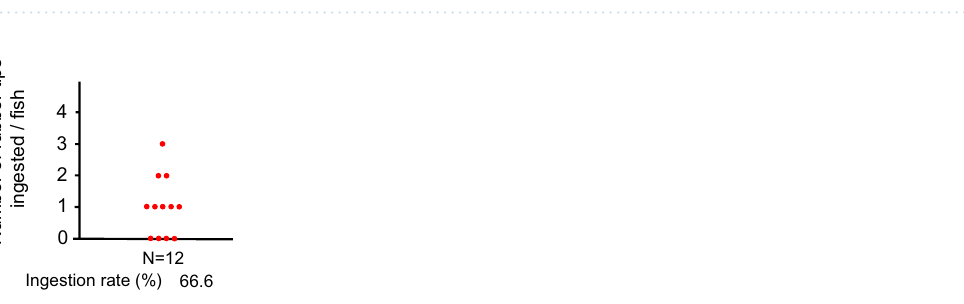
Figure 3. Co-ingestion of rubber tips (ICU) and fish feed by goldfish of different body sizes. Fish were fed a mixture of fish feed and rubber tips. The number of ingested rubber tips in the intestine was counted at dissection. Cont., fish of the control group fed with only fish feed; RT, fish fed with a mixture of fish feed and rubber tips.